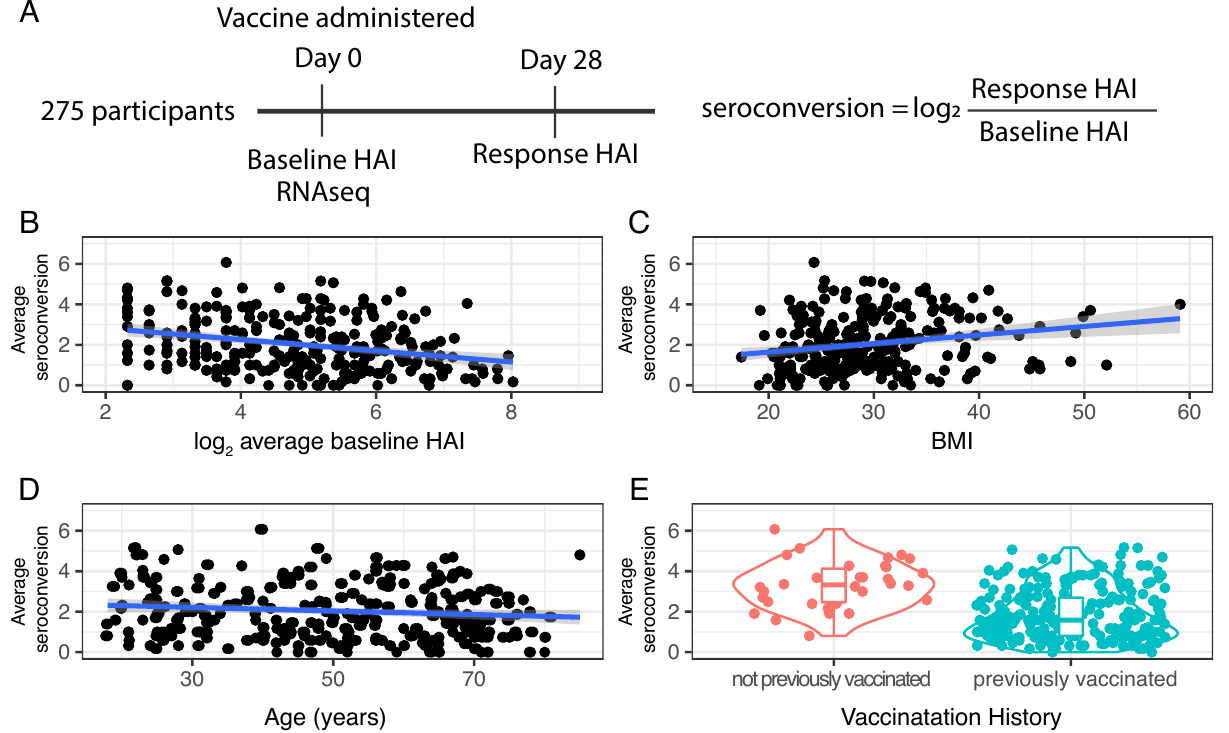
Figure 1. Study design and response to vaccination. ( A ) 275 participants from the UGA4 vaccination study were selected for whole blood gene expression analysis. HAI for four strains was determined prior to vaccination (baseline HAI) and 28 days (response HAI) after vaccination and used to compute an average seroconversion score. ( B ) There is a significant negative relationship between average baseline HAI and average seroconversion ( ρ = − 0.34, p -value = 1.12 × 10 − 8 ). ( C ) There is a significant positive relationship between BMI and average seroconversion ( ρ = 0.21, p -value = 0.0005). ( D ) There is a slight negative relationship between age and average seroconversion ( ρ = − 0.13, p -value = 0.02). ( E ) Those individuals who were not previously vaccinated have higher average seroconversion scores than previously vaccinated